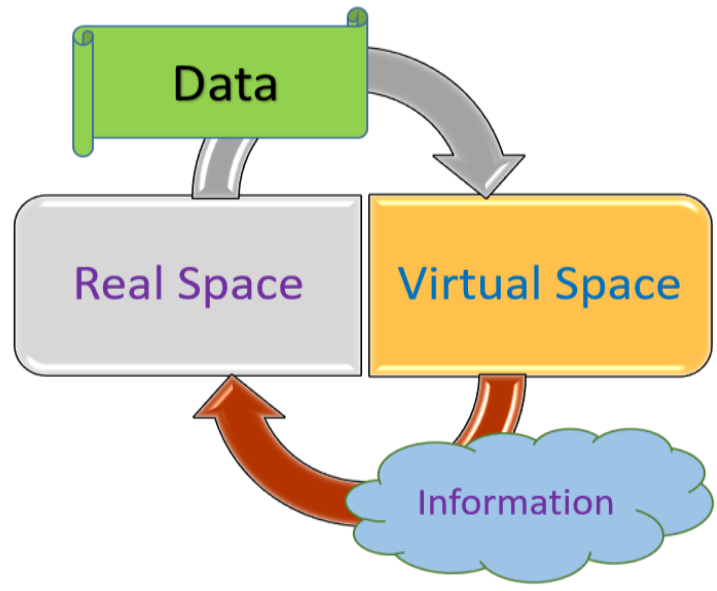
Figure 1. Digital twin — conceptual model.